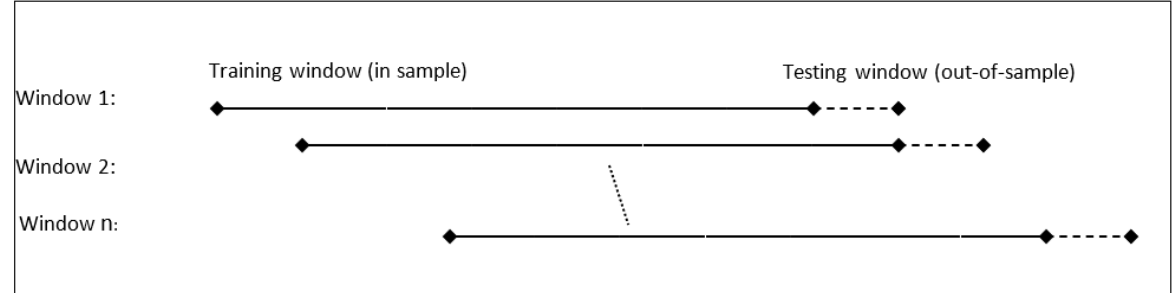
Figure 5. Illustration of 12 rolling windows for the training, validation, and testing sets.